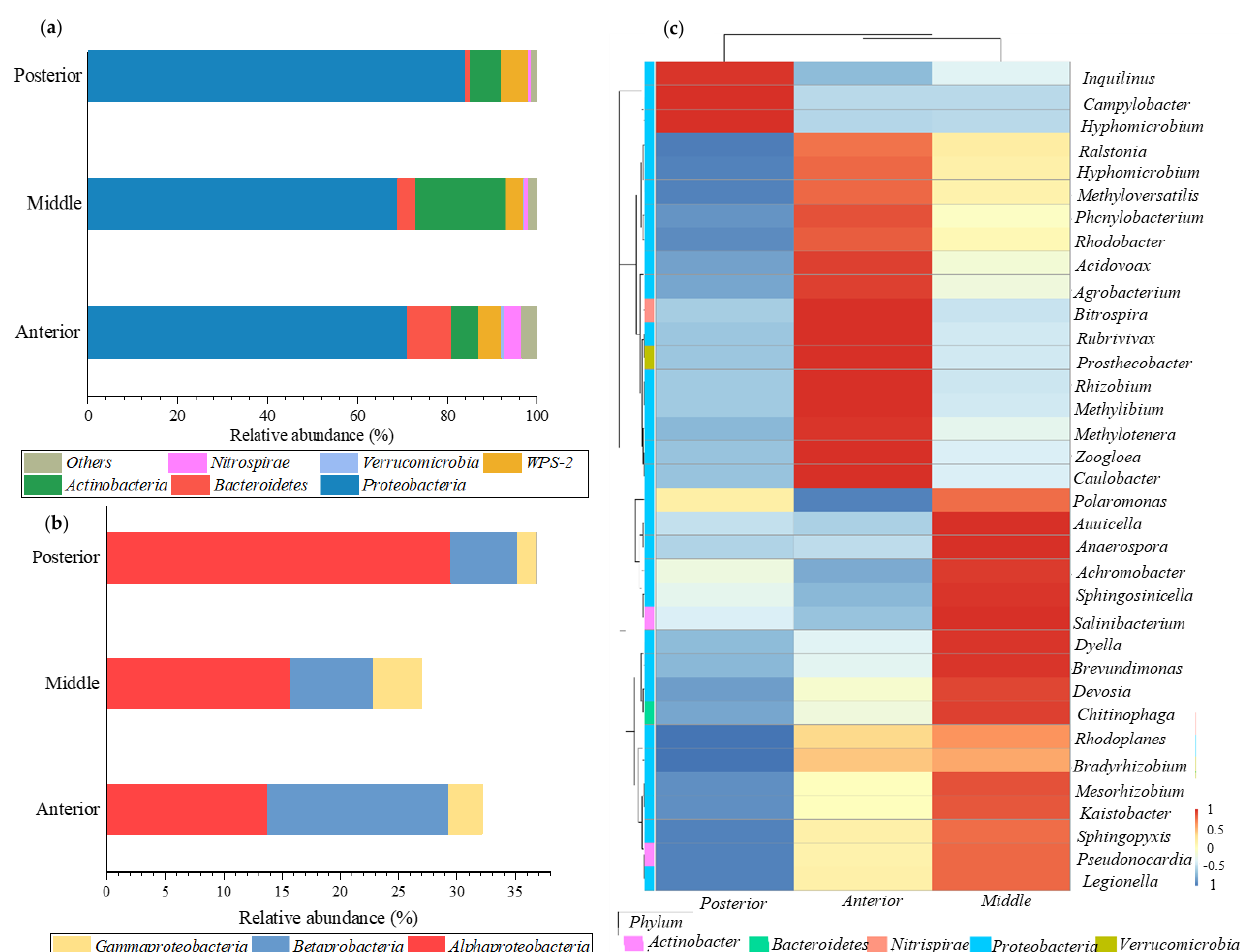
Figure 7. Microbial community composition at the: ( a ) phylum, ( b ) class, and ( c ) genus levels.